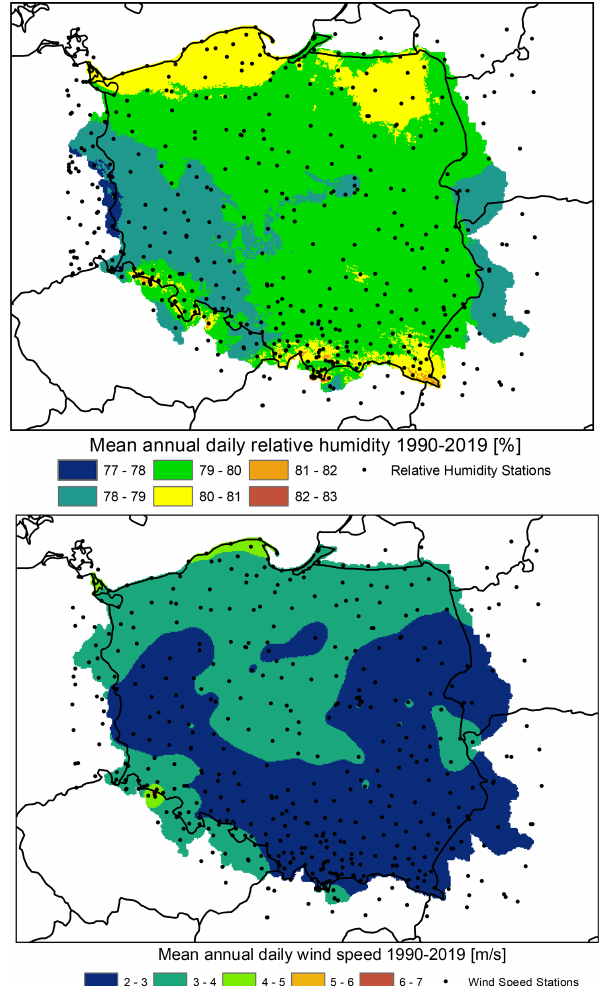
Figure 23. Mean annual relative humidity and wind speed in the time period 1990–2019: output from the G2DC-PL + dataset.